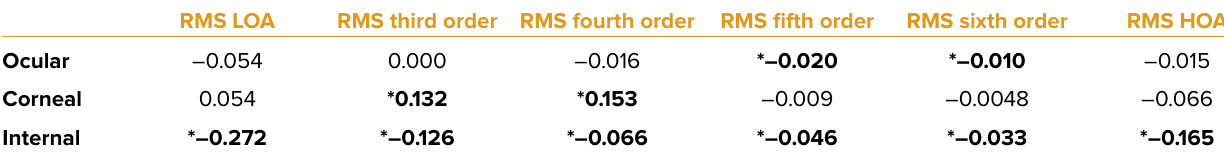
Table 2. Differences between the changes of the computer and paper groups in ocular, corneal, and internal low, third, fourth, fifth, and sixth, and high order root mean square Difference between the changes of the computer and paper groups (μm) RMS LOA RMS third order RMS fourth order RMS fifth order RMS sixth order RMS HOA Ocular –0.054 0.000 –0.016 *–0.020 *–0.010 –0.015 Corneal 0.054 *0.132 *0.153 –0.009 –0.0048 –0.066 Internal *–0.272 *–0.126 *–0.066 *–0.046 *–0.033